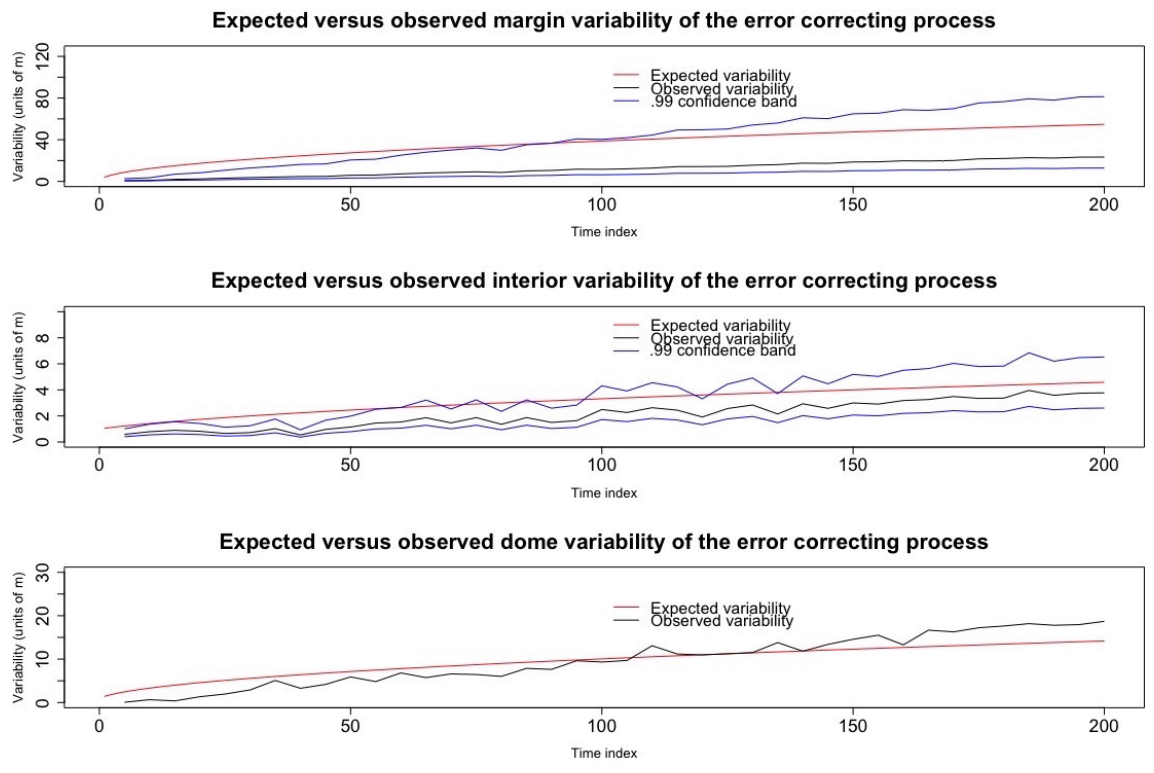
Figure 10. An illustration comparing the expected variability of the error-correcting process (as per the Bayesian hierarchical model) to the observed variability of residuals at the interior, margin, and dome for test case B (i.e., no mass balance field or basal sliding). These residuals are the differences between the observed data and the numerical